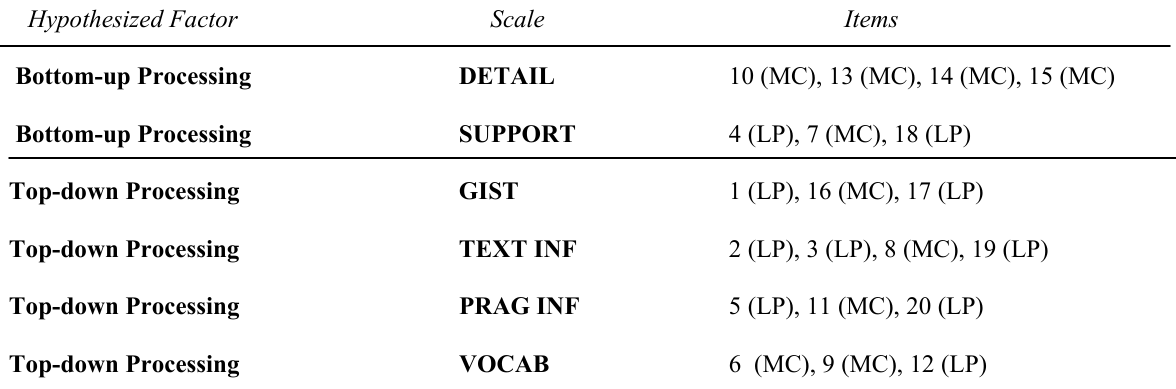
Hypothesized Factors and Scales of Second Language Listening Ability (20